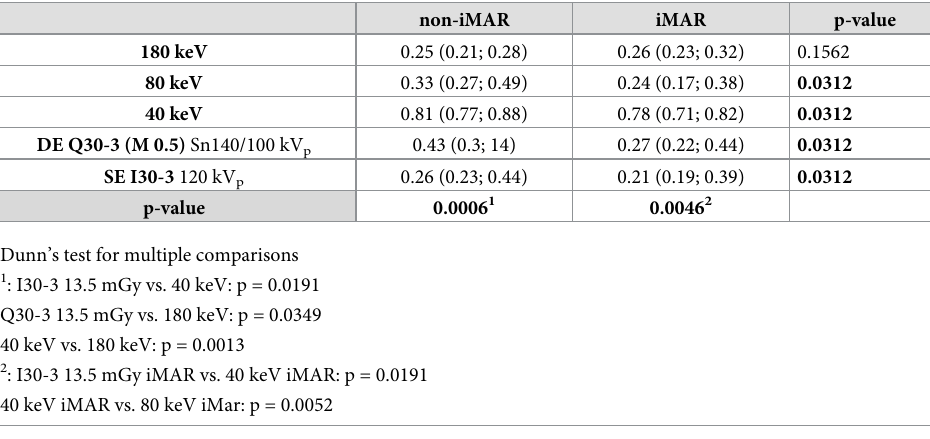
Table 3. Results of threshold based semi-automated segmentation, given as a percentage of the